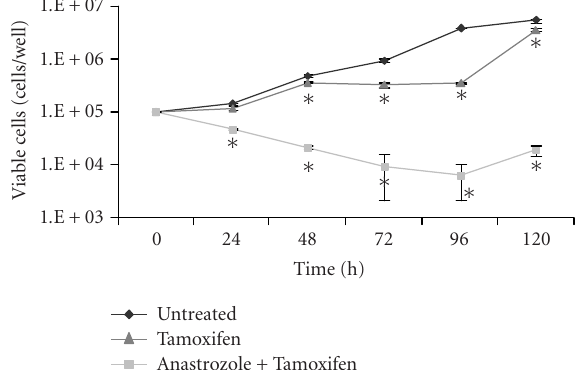
Figure 4. Growth kinetics of untreated, tamoxifen-treated (5 µ g/mL), and combination-treated (anastrozole 50 µ g/mL and tamoxifen 5 µ g/mL) 4T1 cells. Combination treatment drasti- cally reduced cell number throughout the study period. Stars indicate statistical di ff erence in number of viable cells from the untreated groups ( P ≤ . 05). Bars represent ± SEM.